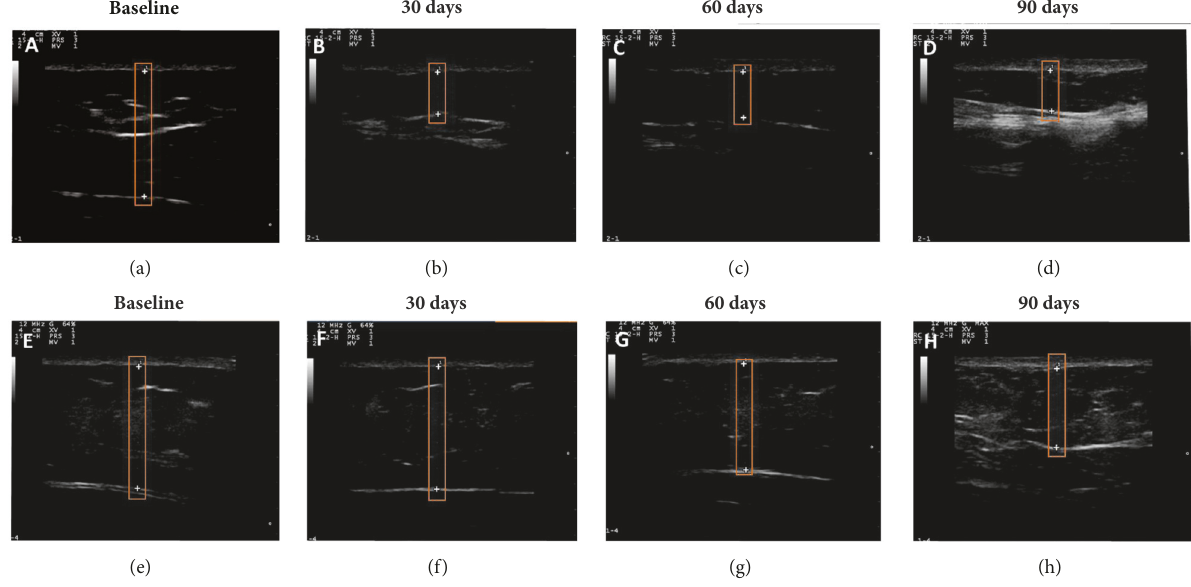
Figure 5: The thickness of the abdominal fat layer (a-d)—(a) at the baseline, (b) at the 30-day follow-up, (c) at the 60-day follow-up, and (d) at the 90-day follow-up—and the thickness of the flanks’ fat layer (e-h): (e) at the baseline, (f) at the 30-day follow-up, (g) at the 60-day follow-up, and (h) at the 90-day follow-up. Note the hyperechoic areas—bright echoes and highly reflective structures (white = dermis fascia and fibrotic septa)—and hypoechoic areas: sparse echoes,reflection, or intermediatetransmission (gray = adipose tissue and skeletal muscle). The boxes indicate the areas compared and the decrease of the thickness after the treatment.